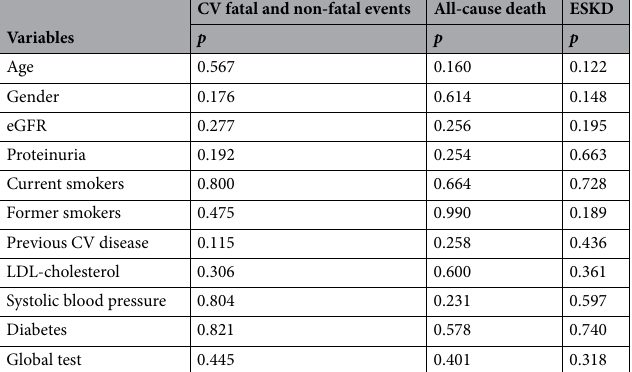
Table 6. Tests of proportional hazard assumptions in survival models (Derived from Table